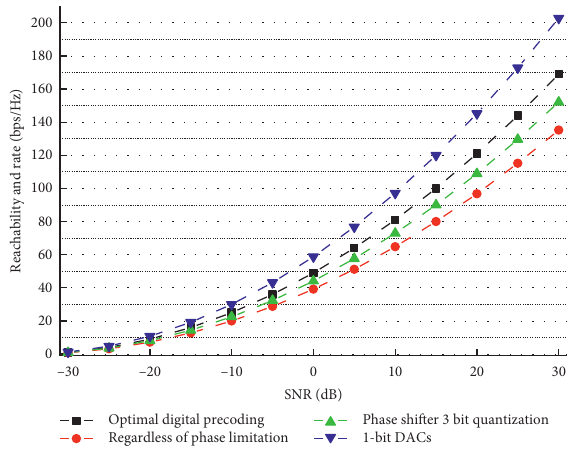
Figure 9: Algorithm performance comparison